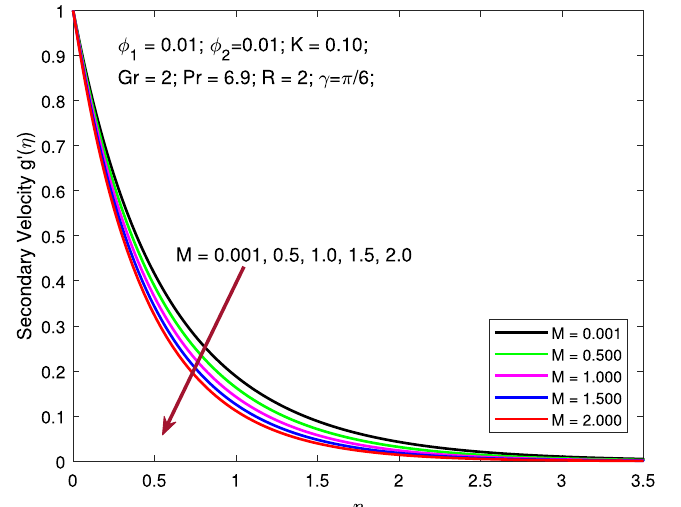
Figure 5. Variation of secondary velocity with MF strength.